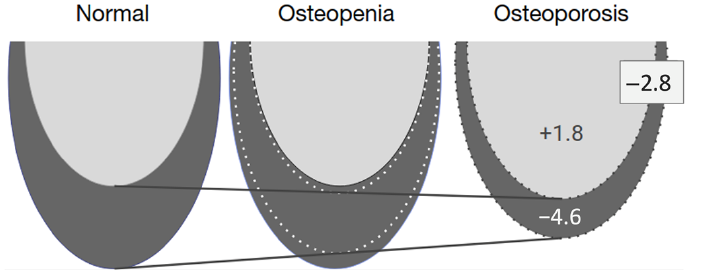
Figure 6. Summary of the adjusted regression model showing a +1.8 mm 2 increase in the trabecular bone volume and a − 4.6 mm 2 decrease in the cortical bone volume, resulting in a net bone decrease of − 2.8 mm 2 in patients with osteoporosis. The trabecular bone is shown in light gray, and the cortical bone is in dark gray.